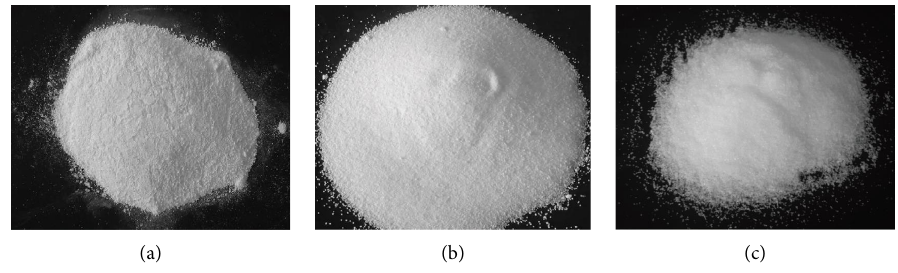
Figure 4: Inert dust samples: (a) SiO